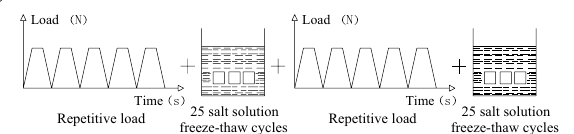
Fig. 4 Methods for the cyclic loading and salt-solution freeze–thaw cycles in the